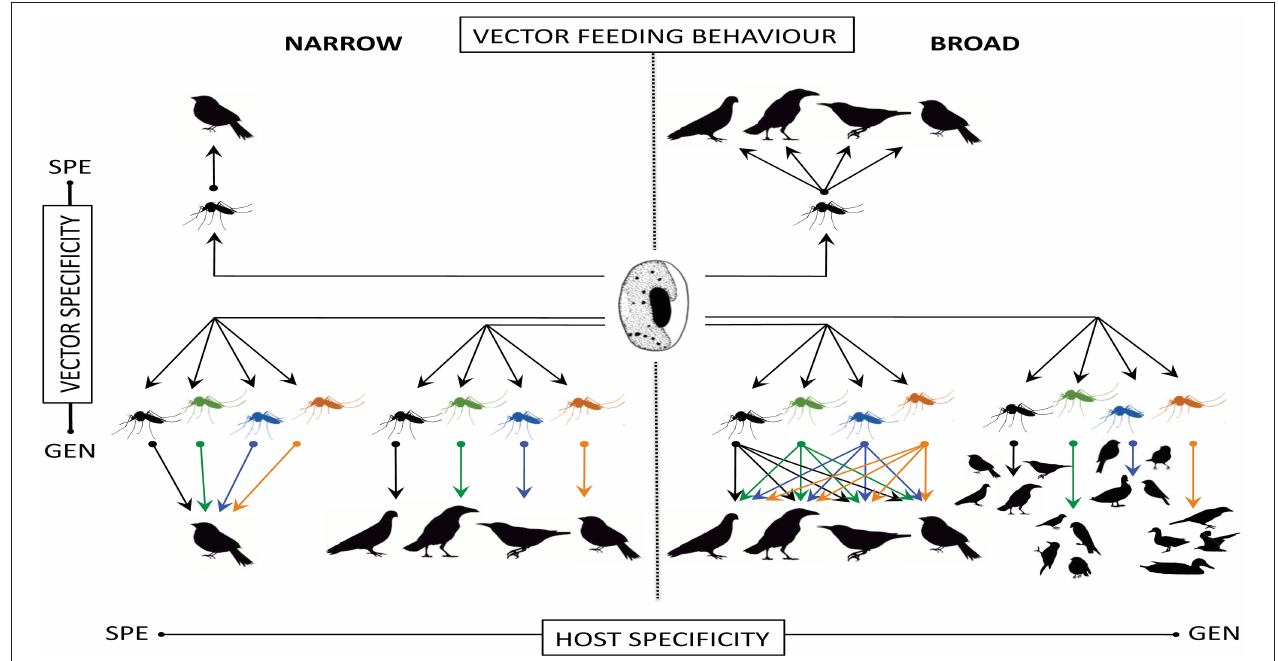
FIGURE 1 | Diagram of the potential interactions between Plasmodium parasite and the mosquito vector and the bird host in function of the feeding preference of the mosquito (narrow or broad: feeding on only one or four bird species, respectively). On the top half part, the parasite is a vector specialist (infecting one mosquito; SPE) and on the bottom part, the parasite is a vector generalist (infecting four mosquitoes; GEN). In each case (Top left: vector specialist and narrow feeding preference; Top right: vector specialist and broad feeding preference; Bottom left: vector generalist and narrow feeding preference; Bottom right: vector generalist and broad feeding preference), only extreme results on the parasite host specificity continuum (bottom line from specialist (SPE) to generalist (GEN) are illustrated. In the case of mixed community of vectors with both narrow and broad feeding preferences (not represented here), the number of infected hosts will vary from 4 to 13. Credit